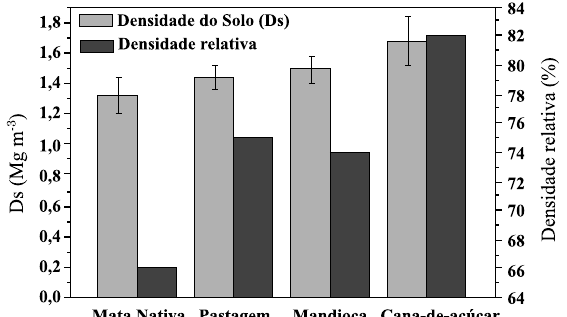
Figura 4. Valores de densidade do solo e de densidade relativa do solo em solos sob mata nativa e cultivados com pastagem, mandioca e cana-de- açúcar, na camada de 0 a 0,10 m. As barras indicam o intervalo de confiança (95 %). As médias são estatisticamente diferentes quando não ocorre sobreposição das barras.